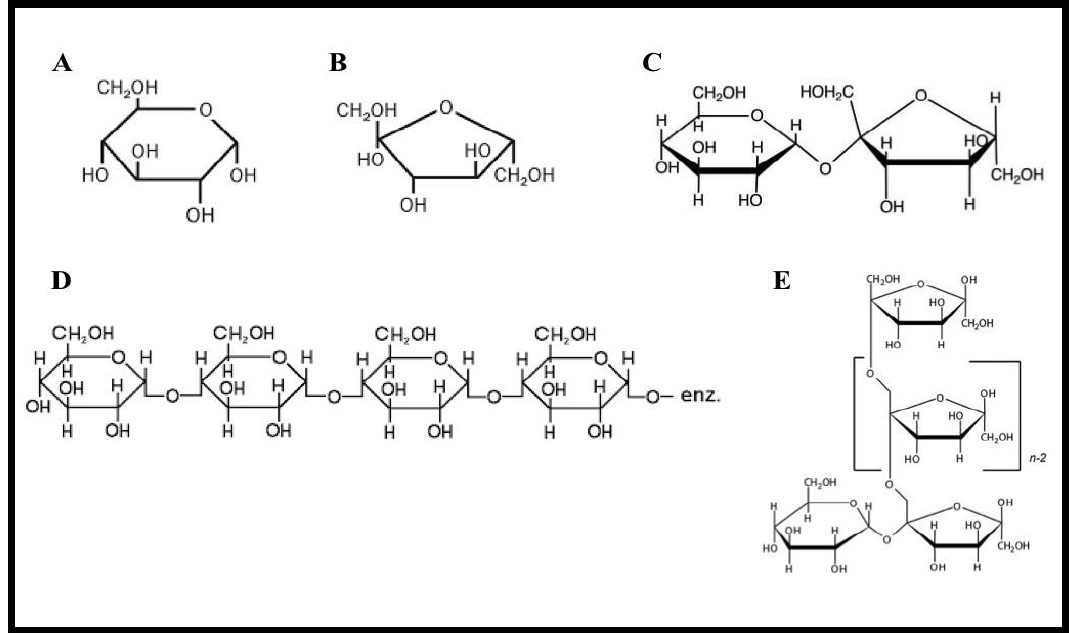
Figure 2. Chemical structures of widely used sugar adulterants in honey. ( A ) Glucose, ( B ) Fructose, ( C ) Sucrose, ( D ) Rice syrup, and ( E ) Inulin syrup.